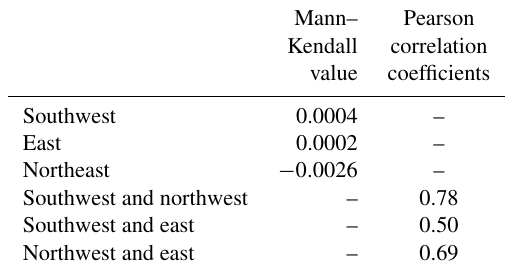
Table 1. Mann–Kendall trend test and correlation coefficients of PDSI values from 1700 to 2013 between the three